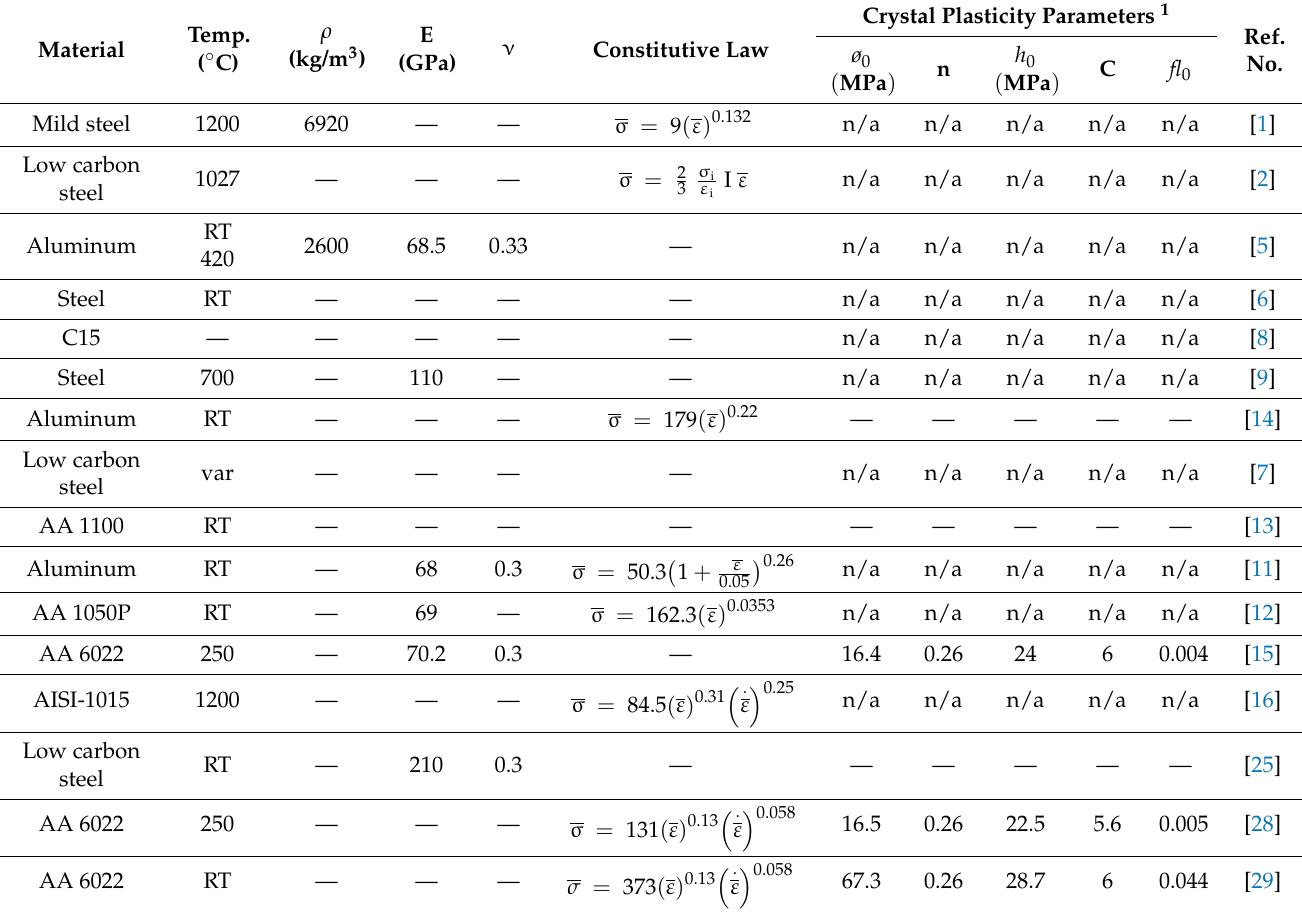
Table 2. Material properties used in ASR simulations by different